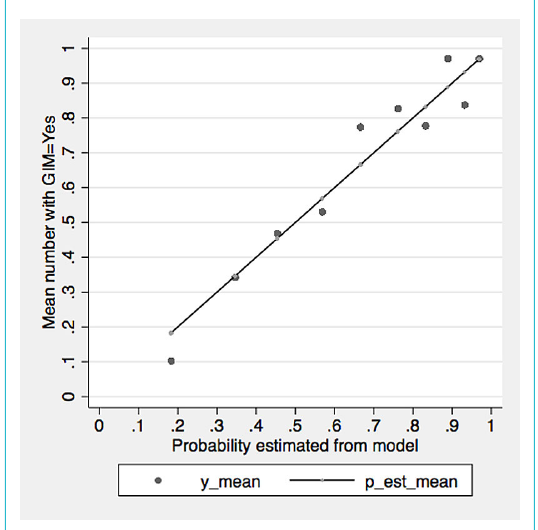
Figure 1: Predictions and actual counts by decile, based on the combined model of logistic regression with the variables named